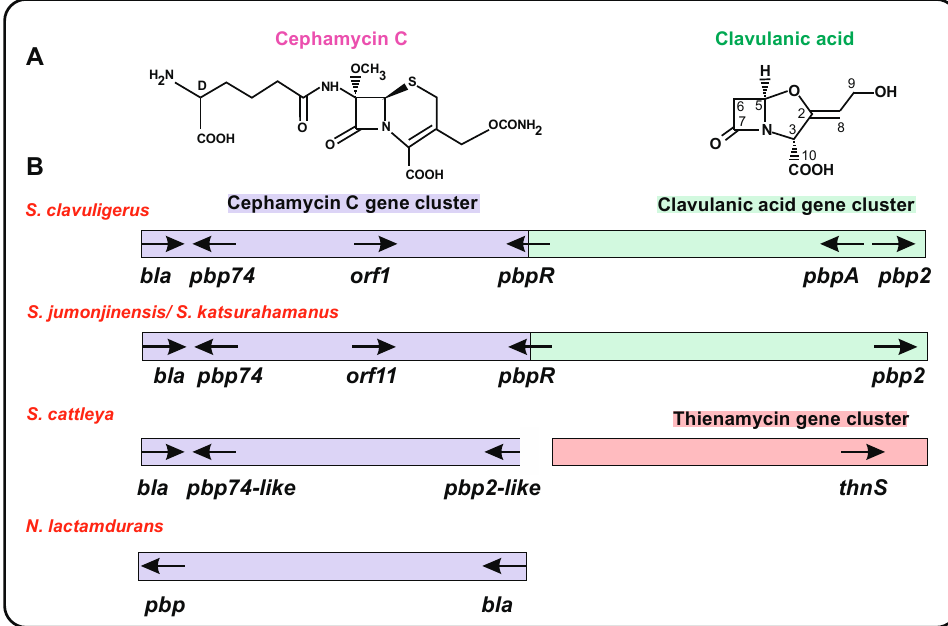
Figure 2. Location of genes related to β -lactam resistance in β -lactam gene clusters. ( A ) Structure of cephamycin C (left side) and clavulanic acid (right side). ( B ) Location of genes encoding β -lac- tamases or PBPs in the cephamycin C gene clusters (purple), clavulanic acid gene clusters (green), and thienamycin gene cluster (pink) of S. clavuligerusm S , jumonjinensis , S. katsurahamanus , S. cattleya , and N. lactamdurans .